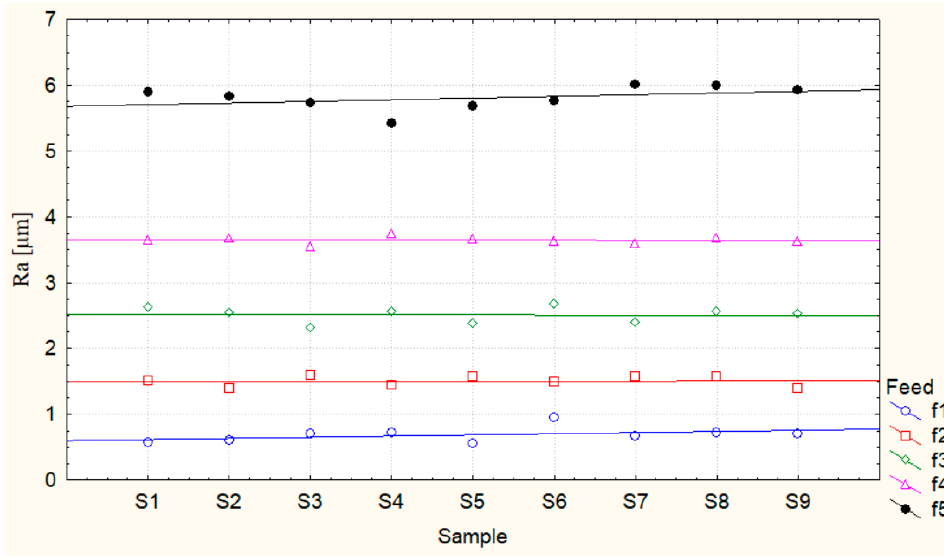
Figure 12. Sca tt er plot of the measurements of R a after turning on the sample sections.